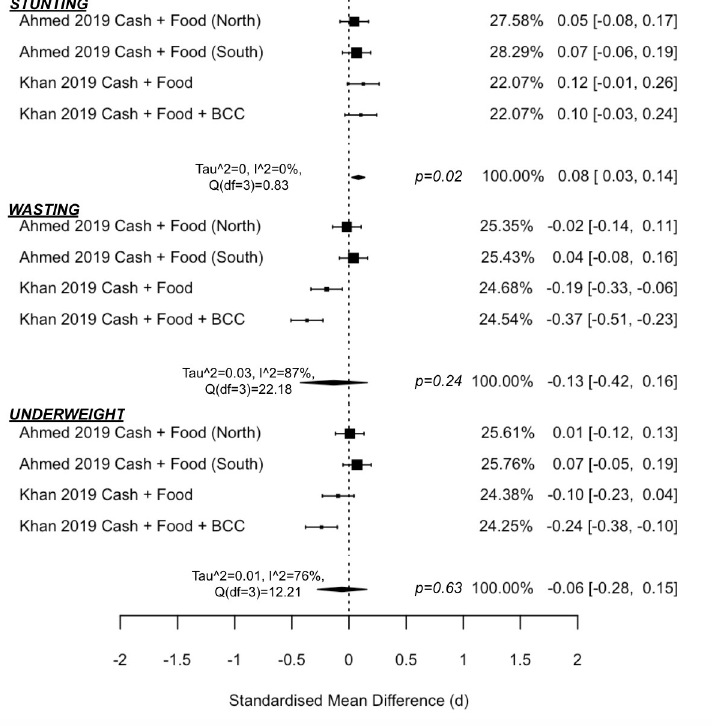
Fig 4. Forest plot of Cash + Food Transfers vs. cash alone on anthropometric z-scores.